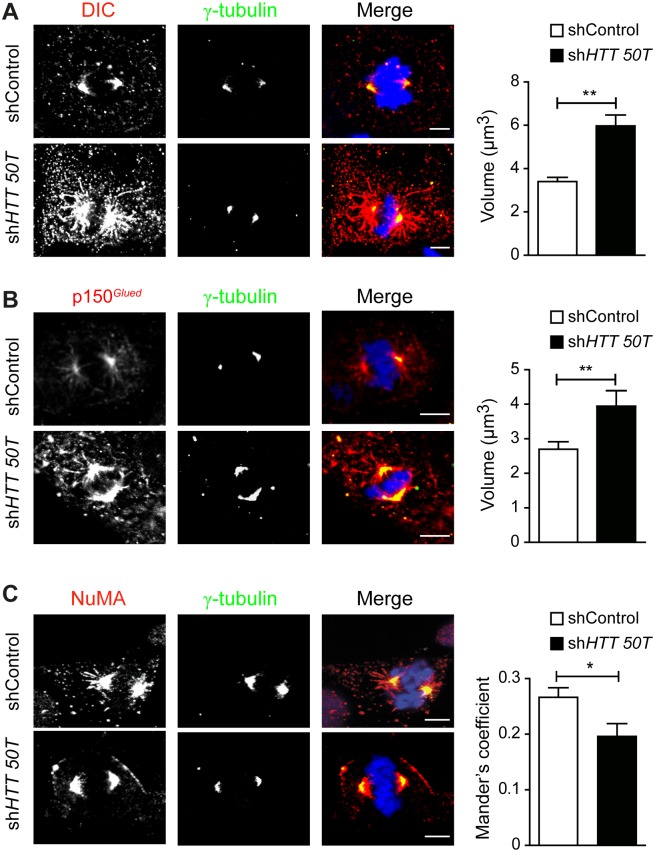
Allele-specific silencing of mutant HTT rescues dynein, p150Glued and NuMA mislocalization in human HD-NSCs.Immunostaining of shControl and shHTT50T-treated metaphasic neural stem cells with anti-DIC (A), anti-p150Glued (B) or anti-NuMA (C) and anti-γ-tubulin antibodies. Nuclei are counterstained with DAPI. Scale bars, 5 μm. Graphs correspond to the quantification of (A): shControl: n = 46 and shHTT50T: n = 46; (B): shControl: n = 54 and shHTT50T: n = 45; (C): shControl: n = 16 and shHTT50T: n = 28 cells analysed in at least 3 independent experiments. Results are shown as mean values ± SEM. ***p<0.001, **p<0.01, *p<0.05; Student’s t test.